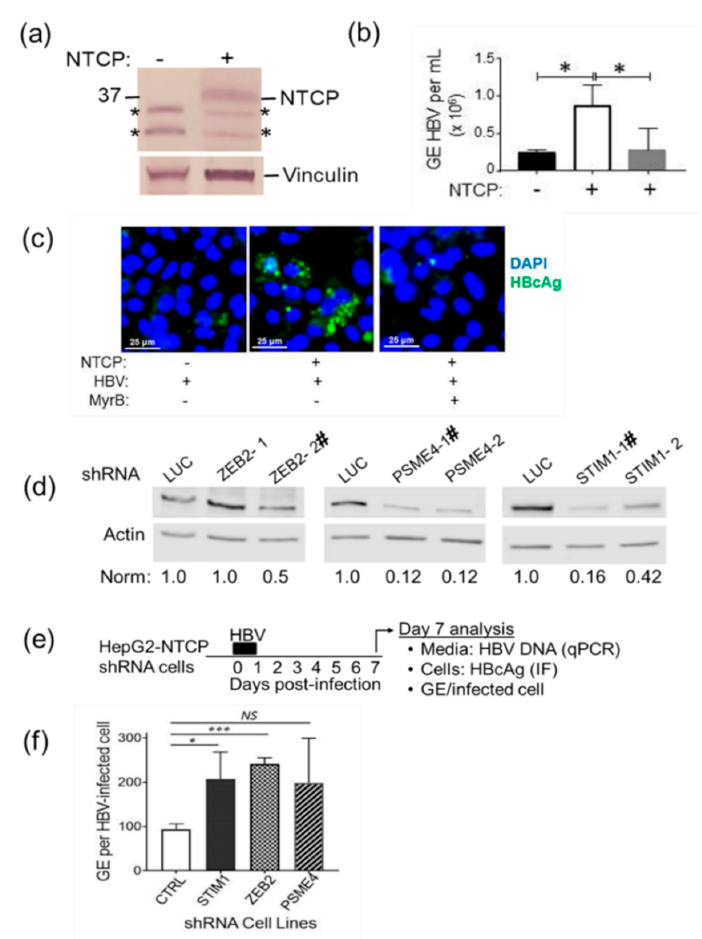
Figure 6. Knockdown of putative restriction factors enhances HBV replication: HepG2 cells overexpressing the HBV receptor sodium-taurocholate cotransporting polypeptide (NTCP) were created as described in the Materials and Methods section. ( a ) Western blot confirmation of NTCP expression: Other bands (indicated by asterisks) are nonspecific. ( b ) HBV DNA was detected in the media of HBV-infected cells as described in the Materials and Methods section and is displayed as genome equivalents (GE) per mL of media. The asterisk (*) indicates p < 0.05. ( c ) Immunofluorescence (IF) staining for HBV core antigen (HBcAg) in cells inoculated with HBV: Only cells overexpressing the NTCP receptor are permissive to HBV infection. Pretreatment of cells with HBV entry inhibitor Myrcludex B (MyrB) reduces both the number of cytoplasmic HBcAg-positive cells and the GE/mL (see panel b), indicating that infection occurs through an NTCP pathway [66,67]. ( d ) Western blot of HepG2-NTCP cells transduced with lentivirus encoding shRNAs to knock down levels of ZEB2, PSME4, STIM1, or LUC negative control. Following SDS-PAGE and western blot analysis, levels of normalized restriction factors in control cells were set to 1.0 and compared to normalized levels in cells with restriction factor knockdown. Cell lines designated “ # ” were used for infection experiments. ( e ) Experimental design for data shown in panel ( f ). HepG2-NTCP shRNA cells were infected in triplicate wells with HBV (see the Materials and Methods section). At seven days postinoculation, media was collected to quantitate GE and the cells were fixed and stained with antibody detecting HBcAg to identify infected cells (see the Materials and Methods section). ( f ) Representative results of infection experiments: GE per infected cell were set to 100% for shLUC control cells and compared to levels in the media of shRNA knockdown cells. The increased replication in shZEB cells was reproduced in 3 independent experiments 3 wells per experiment. Increased replication in shSTIM1 or in shPSME4 cells was reproducible in about 75% of experiments but was not always statistically significant due to well-to-well variability. Significance was determined by student t test using GraphPad Prism Version 8.1.2. (* p < 0.05, *** p <